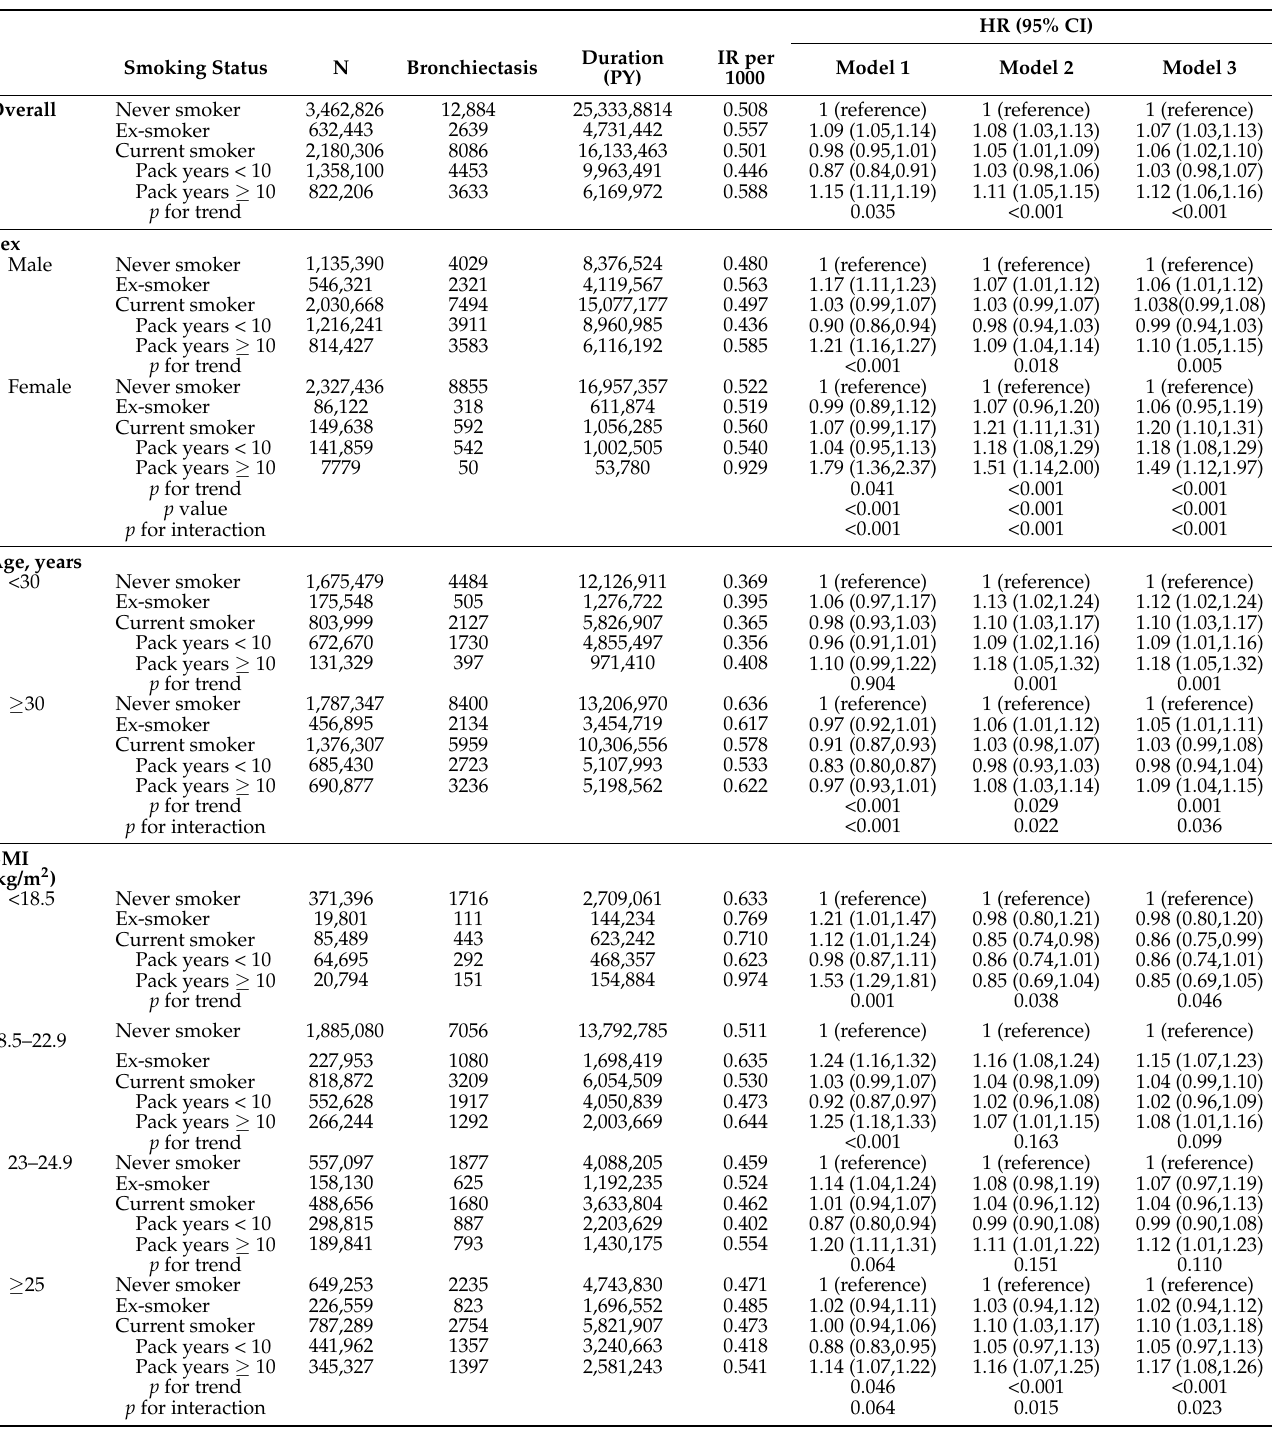
Table 2. Association of smoking status with the incidence of